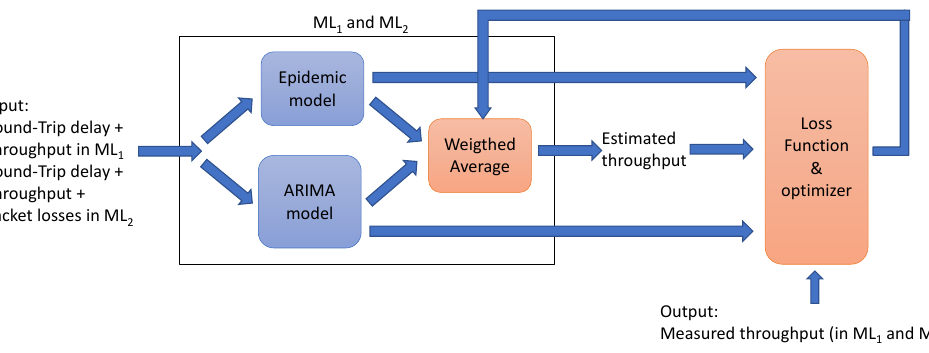
Figure 5. Scheme for ML 1 and ML 2.